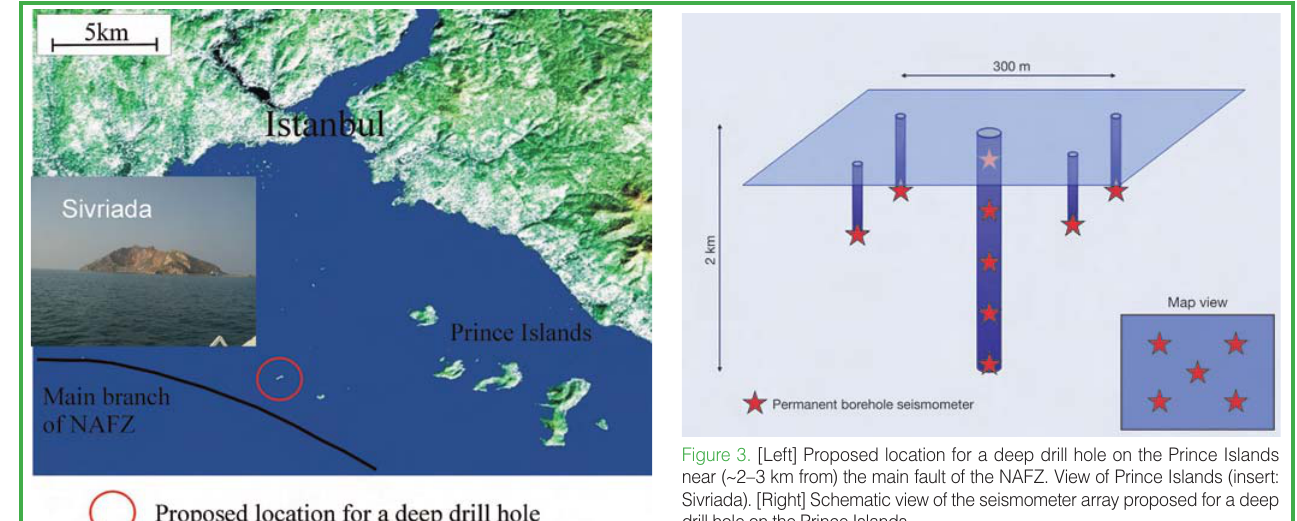
Figure 3. [Left] Proposed location for a deep drill hole on the Prince Islands near (~2–3 km from) the main fault of the NAFZ. View of Prince Islands (insert: Sivriada). [Right] Schematic view of the seismometer array proposed for a deep drill hole on the Prince